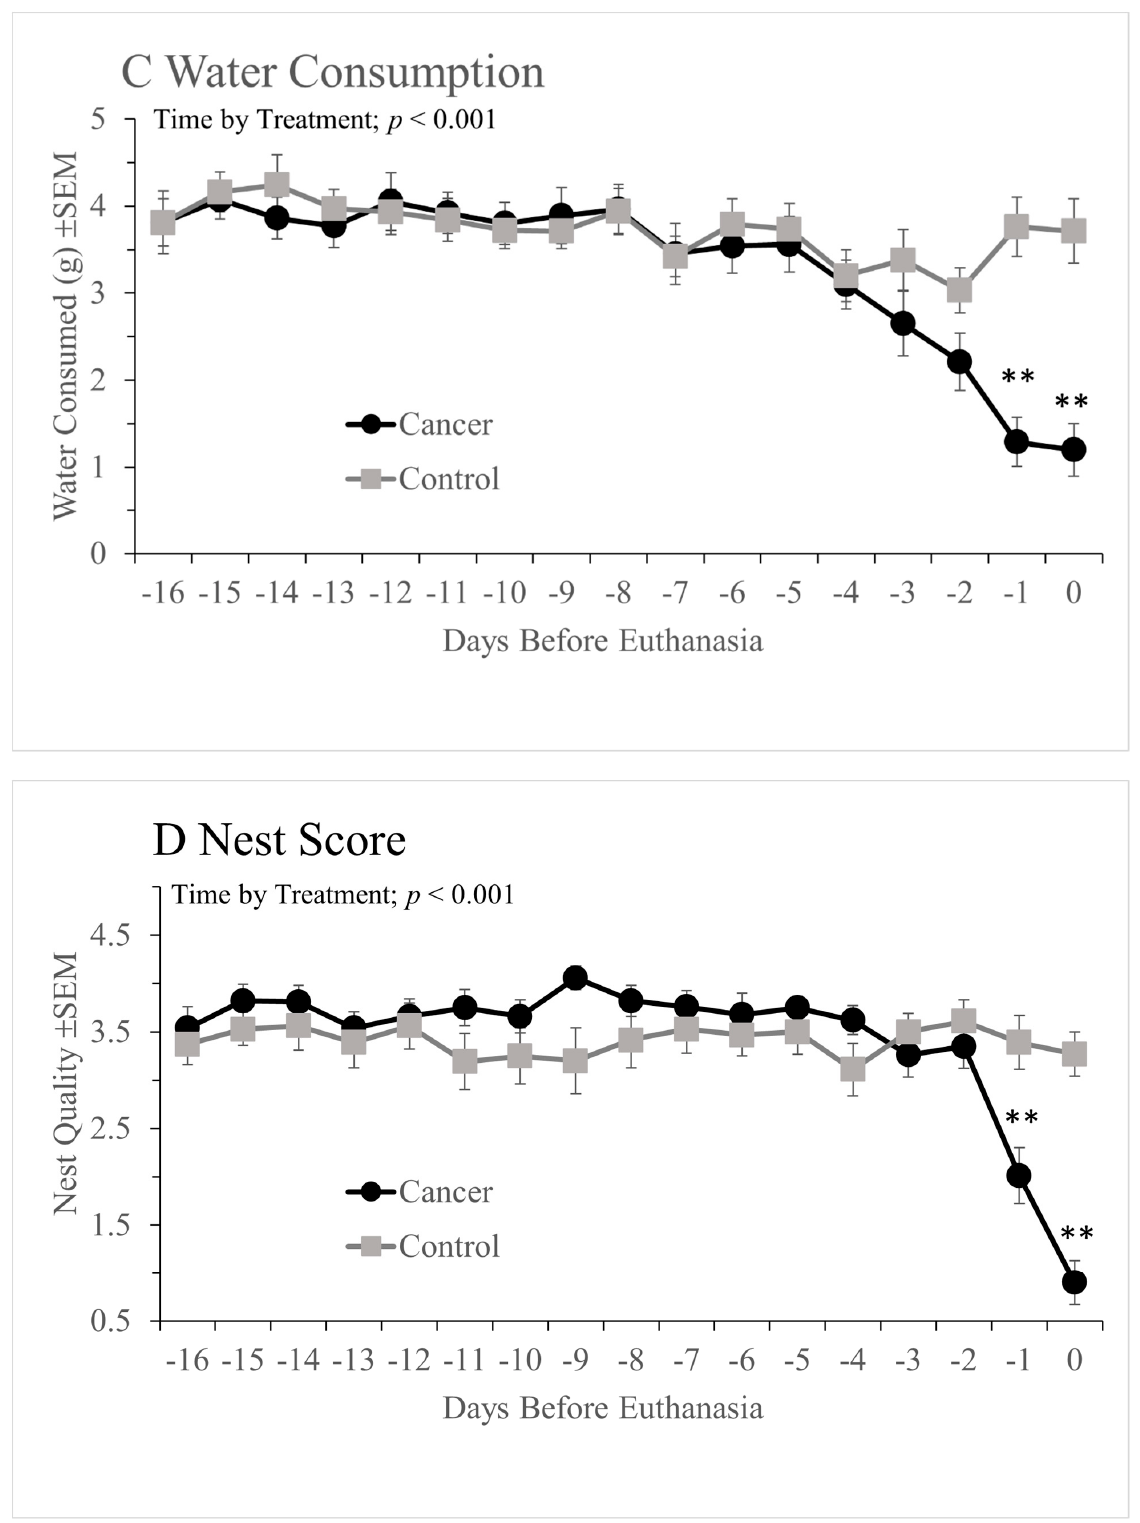
Figure 2. Mean daily body weight ( A ), food consumption ( B ), water consumption ( C ) and nest quality ( D ) in the cancer or control groups during the final 17 days before each mouse was euthanized (Day − 16 to 0 inclusive). Asterisks denote the results of post-hoc analyses, i.e., days on which the cancer or control groups differed significantly (*, p < 0.05; **, p < 0.01: after Bonferroni correction). Note that while nest building ( C ) declined most dramatically (2 to 3 days before euthanasia), reduced food consumption was detected up to 4 to 5 days prior to euthanasia ( B ). Each figure ( A – D ) shows there was a significant ‘Time’ by ‘Treatment’ interaction; p < 0.001. Cancer/Control, n =